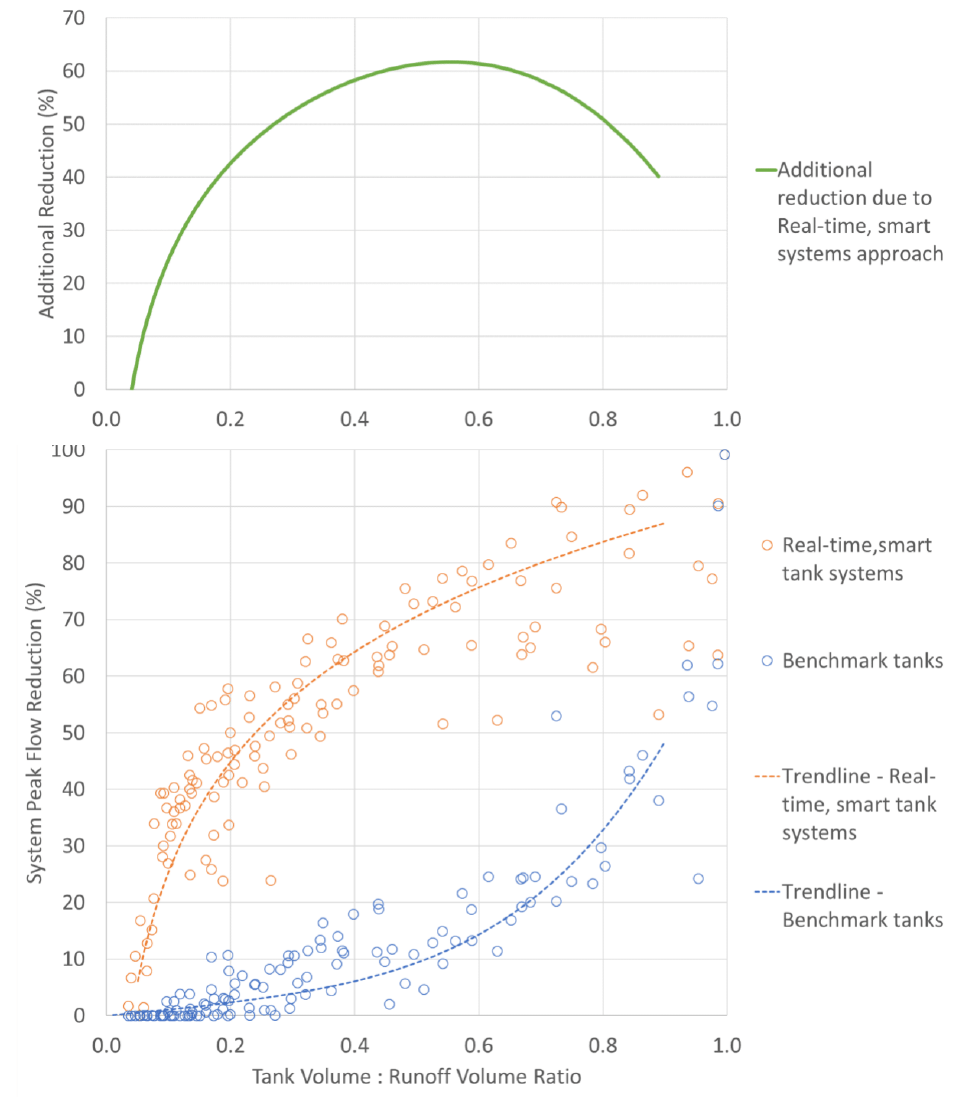
Figure 6. Relationship between the ratio of tank to runo ff volume and peak flow reduction for all computational experiments (i.e., for all locations, AEPs, rainfall durations, and tank sizes considered) for benchmark tanks (blue circles and dashed line) and real-time smart tank systems (orange circles and dashed line). The green solid line represents the additional peak flow reduction that can be achieved by using real-time smart tank systems control based on the di ff erence between the two trendlines fitted to the data sets. The trendlines were developed by trial and error and visual inspection for data where x < 0.9 (Trendline—Real-time, smart tank systems: y = 2 × ln( x ) + 90 (r 2 = 0.7953) and Trendline—Benchmark tanks: y = 70 x 4 − 20 x 3 + 10 x 2 + 10 x (r 2 = 0.8327). Results for tank to runo ff volume ratios in excess of 1 are not shown, as they all result in peak flow reductions of